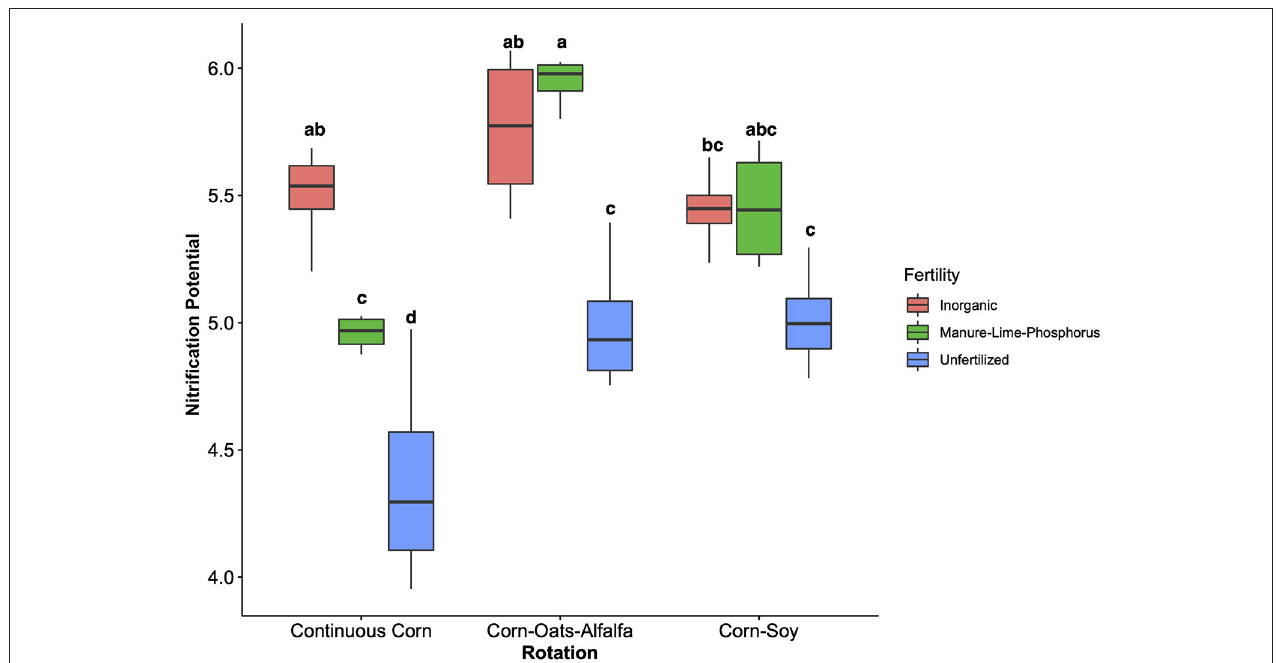
FIGURE 1 | Nitrification potential by management treatment (fertility and rotation). Nitrification potential is measured in µ g NO 2 -N g − 1 DM − 1 hr − 1 and natural log transformed to assume normality. Tukey’s HSD was used for separations of group means, and group membership is indicated via lettering on top of each bar. Model coefficients and P -values are reported in Table 1 . Fertilization and rotational treatments are as follows: manure-lime-phosphorus (MLP), inorganic urea fertilizer (IN), unfertilized (UF); corn-oat-alfalfa (COA), corn-soy (CS), continuous corn (CC).